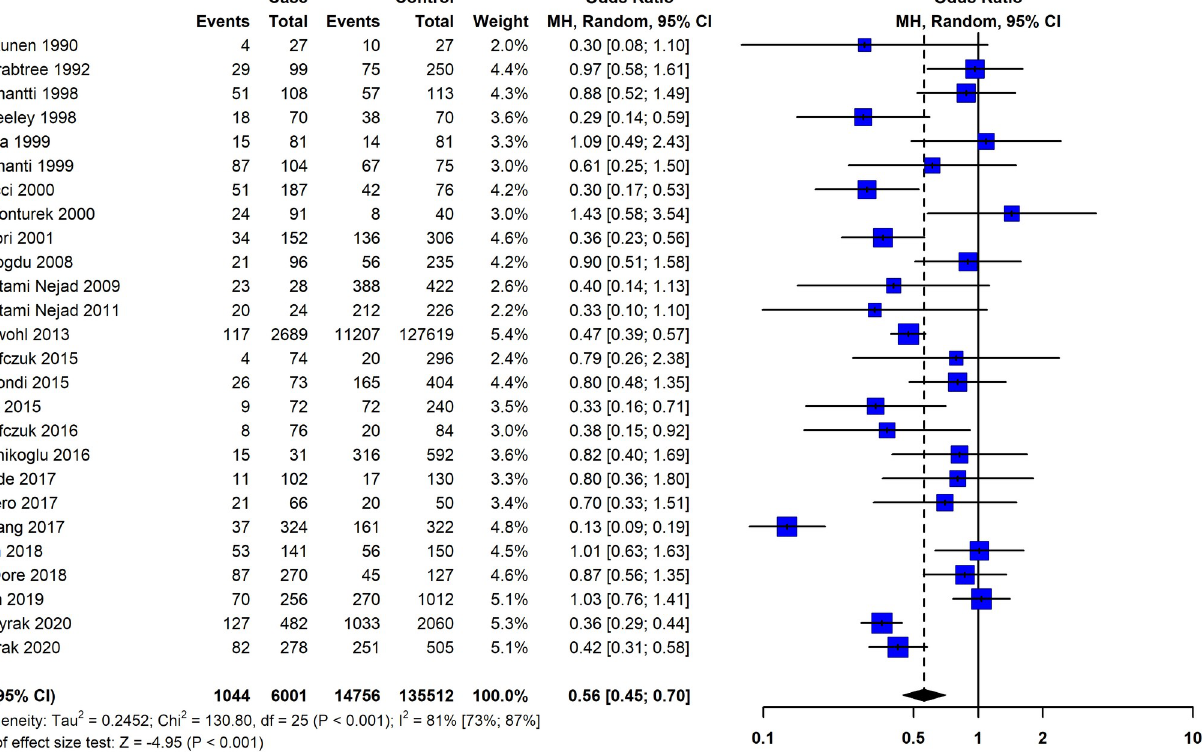
PLOS ONE | https://doi.org/10.1371/journal.pone.0241156 March 3,